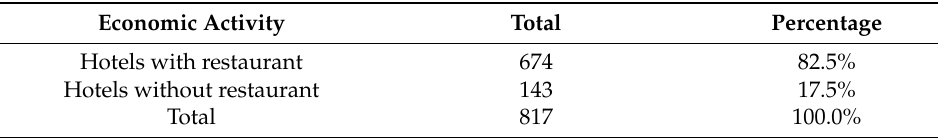
Table 6. Restaurants in hotels.